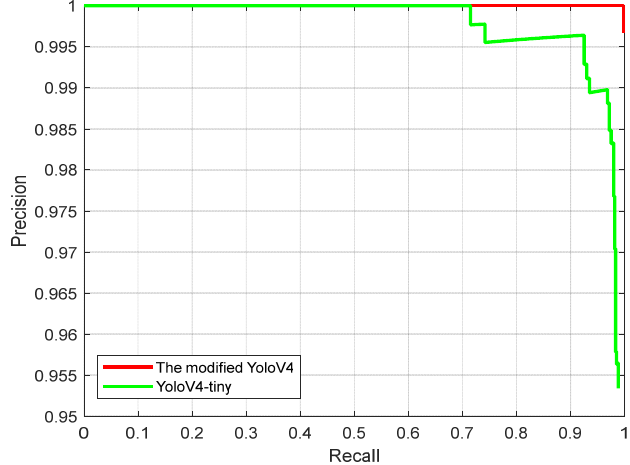
Figure 7. Precision recall curves of the two networks (IoU = 0.5). Table 2. Dataset Composition.